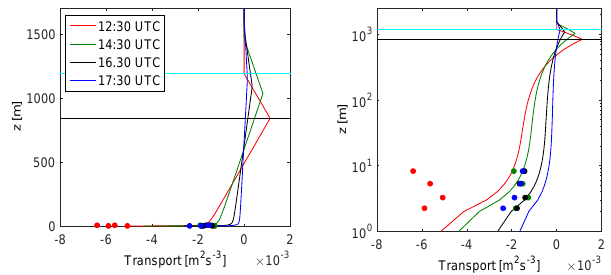
Figure 4. Same as Fig. 3 but for the transport term of the TKE